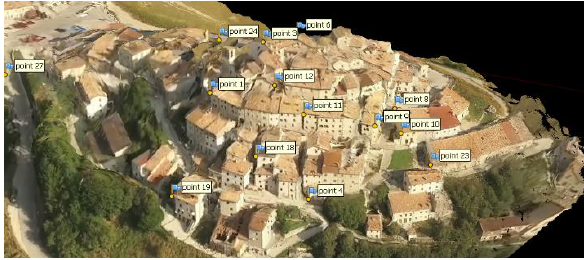
Figure 5. Position of GCPs in the pre-earthquake model